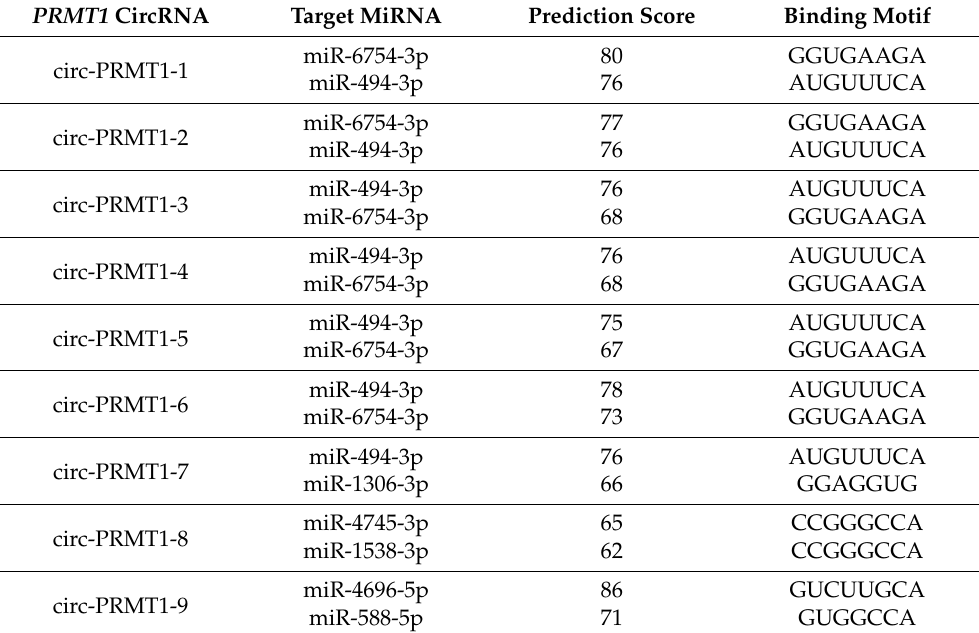
Table 2. The miRNAs that are predicted to bind to the novel PRMT1 circRNAs with the two highest prediction scores, on a scale up to 100. For each miRNA, their binding motif on the respective circRNA sequence is shown as well. Target MiRNA Prediction Score Binding